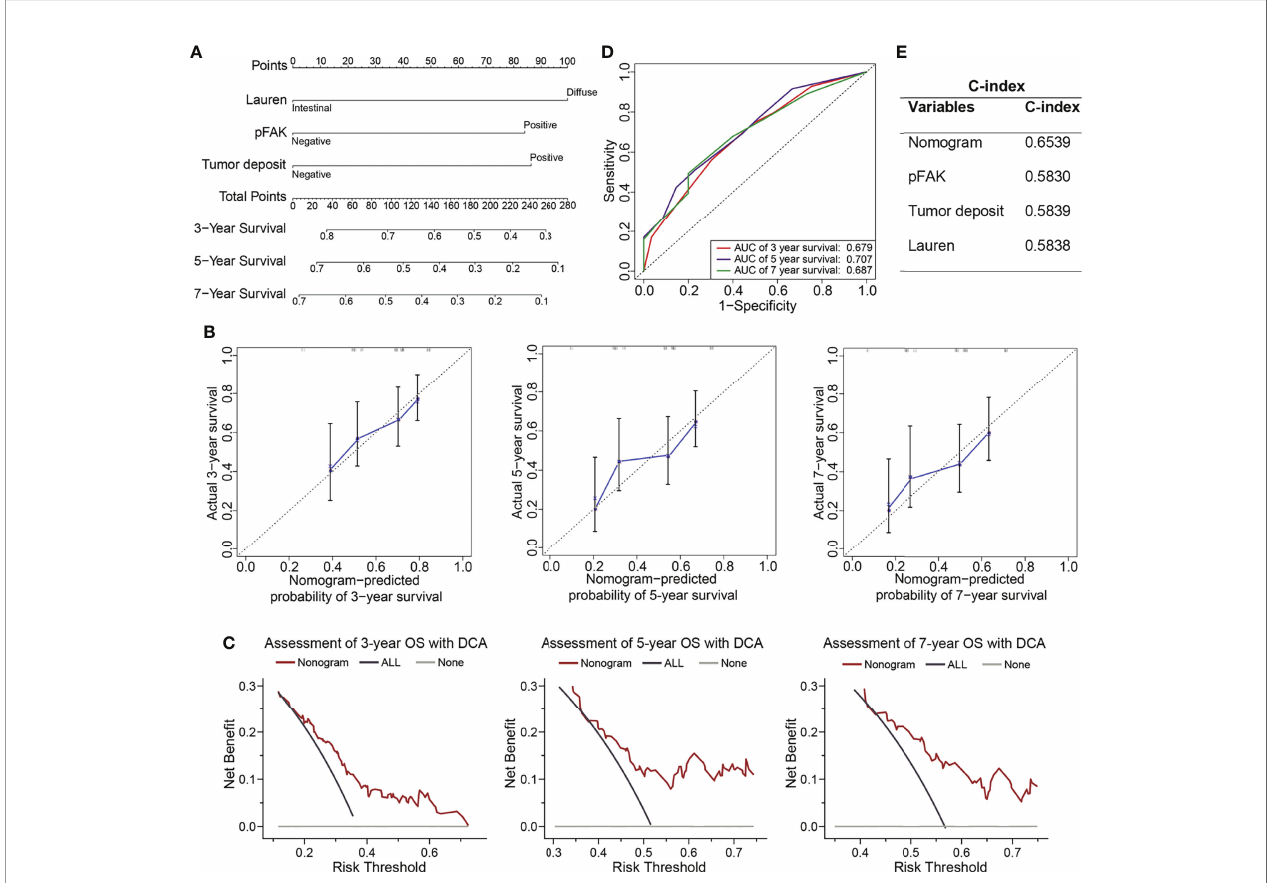
FIGURE 3 | Construction of prognostic nomograms in GCs. (A) The nomogram was constructed to predict overall survival (OS) for GC patients. The value of each variable (Lauren classi fi cation, pFAK and tumor deposit) was added to get the total points. The probability of 3-, 5-, or 7-year OS could be calculated by drawing a vertical line from the total point axis to the probability scale. (B) Calibration curves for 3-, 5-, and 7-year OS of GC patients. The actual OS and the nomogram- predicted probability of OS are plotted on the y -axis and x -axis, respectively. The dotted line along 45° represents a perfect consistency between observed and predictive values. (C) Calibration curves for 3-, 5-, and 7-year OS of GC patients. (D) ROC curves for 3-, 5-, and 7-year OS of GC patients. (E) C-index for nomogram, Lauren classi fi cation, pFAK or tumor